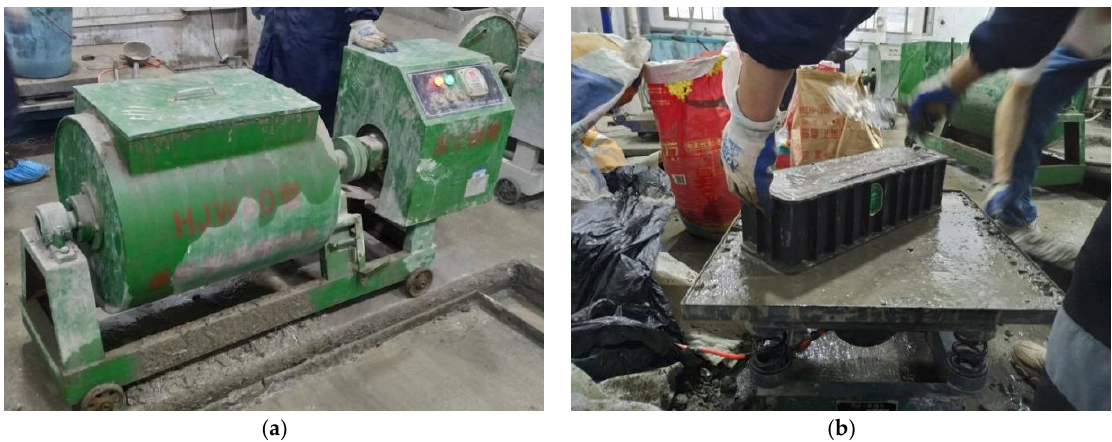
Figure 4. Test process. ( a ) Cement mixer. ( b ) Cement mortar pounding process.